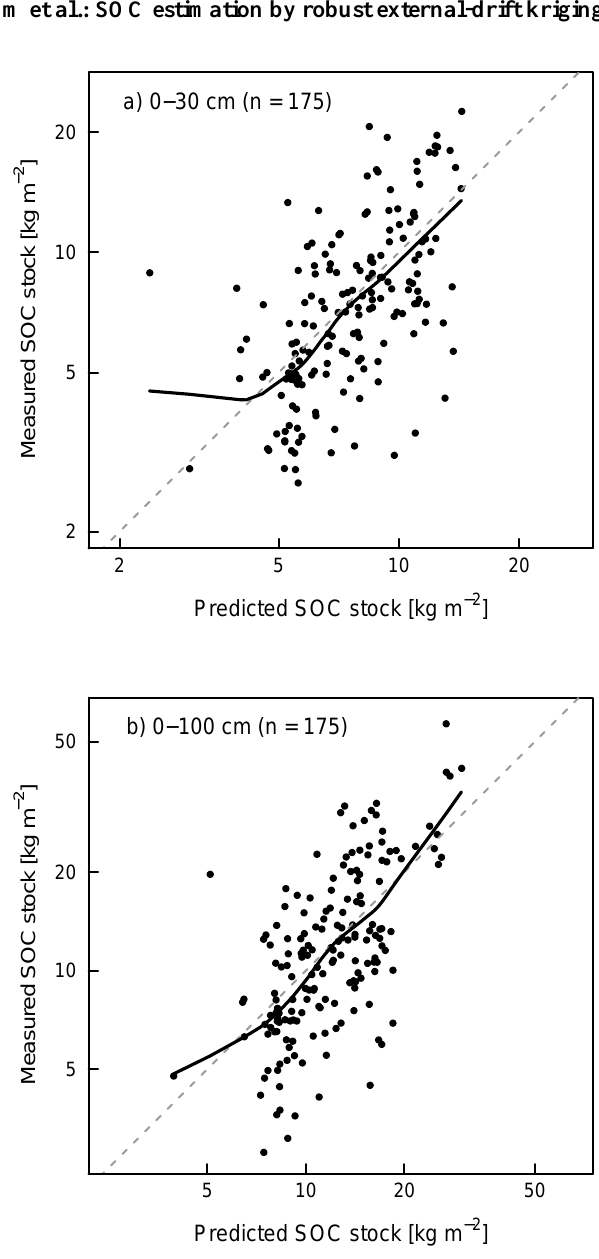
Figure 4. Scatter plots of measured against predicted soil organic carbon (SOC) stocks in 0–30cm (a) and 0–100cm (b) of the min- eral soil, computed with the calibration data for the sites of the val- idation set (solid line: loess scatter plot smoothers, n : number of